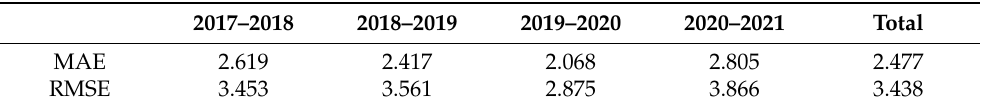
Figure 8. Comparison of sown area (thousand ha) obtained from planting pattern maps with area obtained from national statistical data (( a ) is the year of 2017–2018, ( b ) is the year of 2018–2019, ( c ) is the year of 2019–2020, ( d ) is the year of 2020–2021; y is the area from cropping map, x is the area from the national statistics, R 2 is the determination coefficient, and n is the is the number of cities/counties). Table 2. Comparison of sown area (thousand ha) obtained from planting pattern maps and from national statistical data.